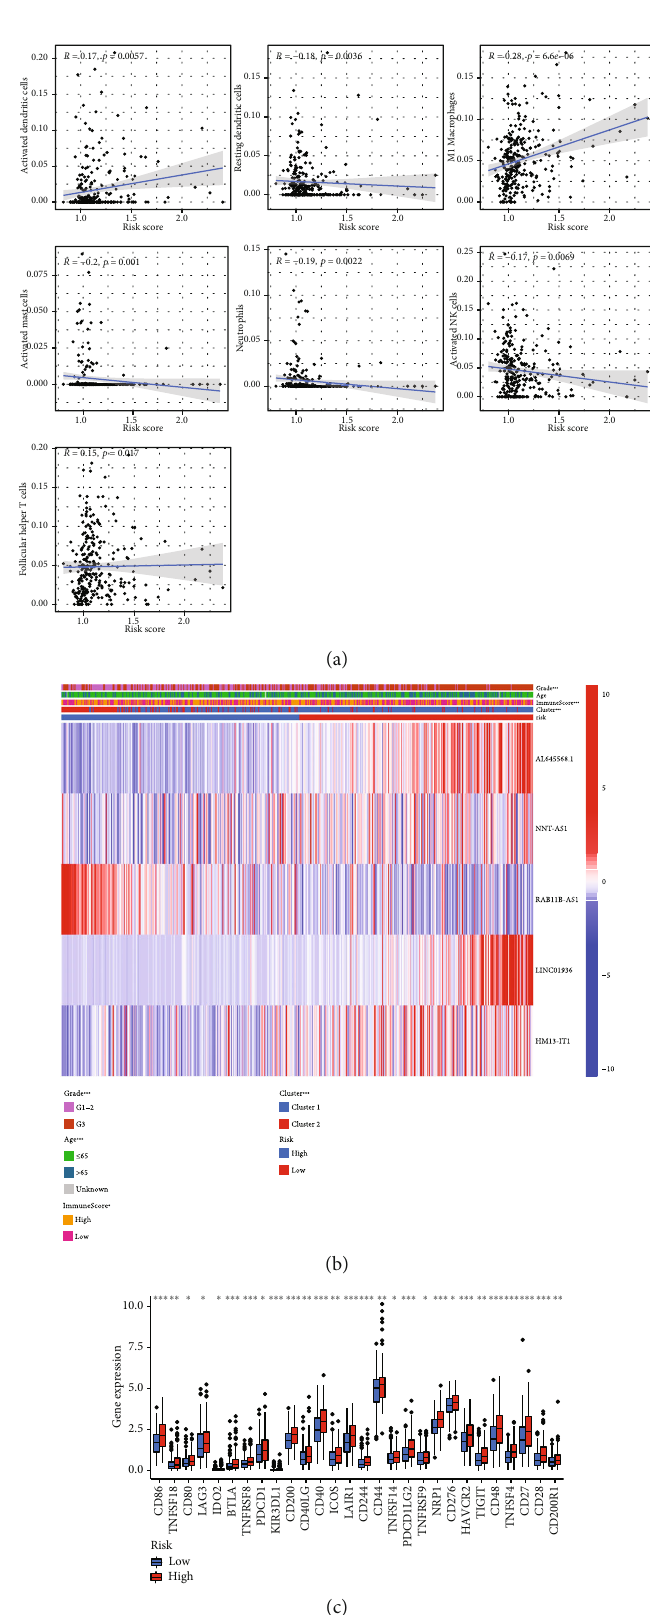
Figure 7: (a) Correlation of the risk scores and immune cells. (b) Relationship between the key long noncoding RNA expressions and the grade, age, immune score, and clusters between di ff erent patient risk groups. ∗ p < 0 : 05 ; ∗∗ p < 0 : 01 ; ∗∗∗ p < 0 : 01 . (c) Expression of the immune checkpoint in di ff erent risk score